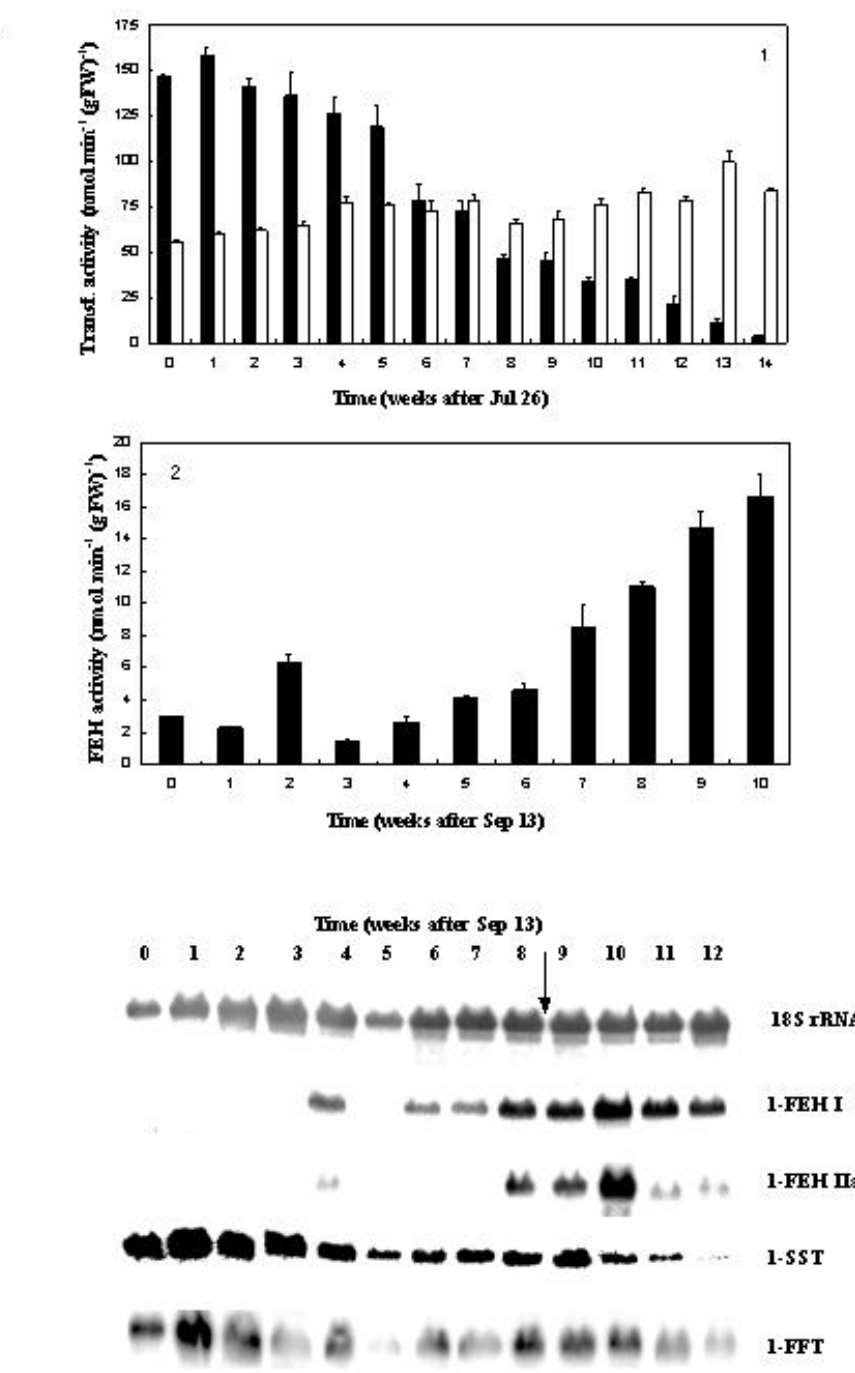
FIGURE 3. (A) The transferase activities (1) of 1-SST (black bars, 100 mM sucrose as substrate) and 1-FFT (white bars, 10 mM 1- kestose as substrate) in chicory roots during field growth. The hydrolase activities (2) of 1-FEH (1% chicory inulin as substrate) in chicory roots throughout autumn. Bars represent standard errors for n = 3. (B) Expression of chicory genes. Northern blot containing RNA from mature field-grown chicory roots throughout autumn and subsequent storage for 3 weeks in a cold room (arrow indicates start of storage). 1-SST, 1-FFT, 1-FEH I, 1-FEH IIa, and 18S rRNA specific probes were